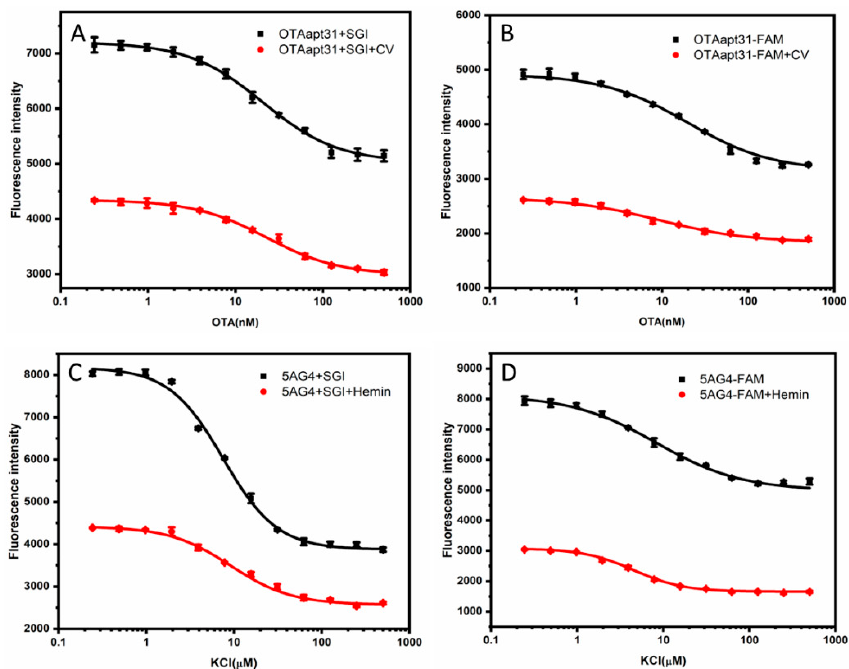
Figure 2. ( A ) Changes of SGI fluorescence response curves of antiparallel G-quadruplexes before and after adding CV at different OTA concentrations ( B ) Changes of FAM fluorescence response curves of antiparallel G-quadruplexes before and after adding CV at different OTA concentrations. ( C ) Changes of SGI fluorescence response curves of parallel G-quadruplexes before and after adding Hemin at different K + concentrations ( D ) Changes of FAM fluorescence response curves of parallel G-quadruplexes before and after adding Hemin at different K + concentrations. The error bar represents the standard deviations of the three parallel experiments.